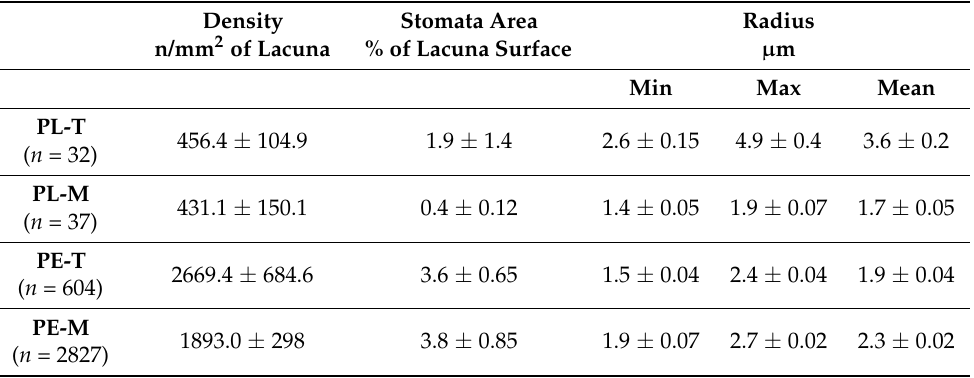
Table 1. Average density, total stomata area (expressed as % of total area of submesothelial lacunae) and stomata radius in diaphragmatic lymphatics. PL-T: pleural-tendinous; PL-M: pleural-muscular; PE-T: peritoneal tendinous; PE-M: peritoneal-muscular. Data are presented as mean ± SD. Number of observation in brackets.